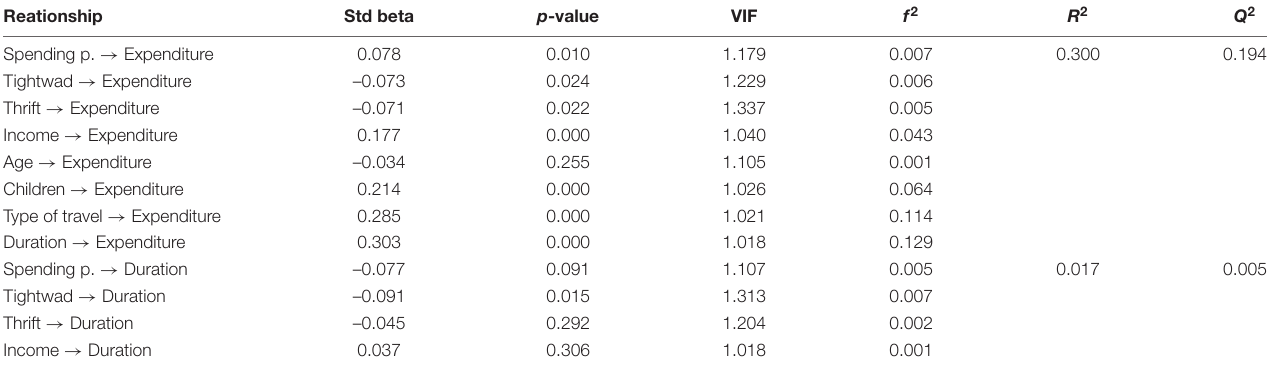
TABLE 5 | Assessment of the structural